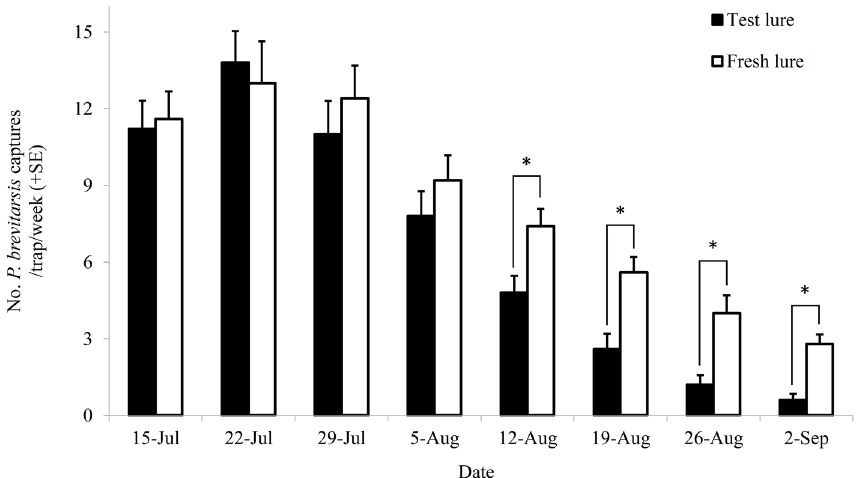
Figure 6. Captures of Protaetia brevitarsis adults in traps baited with test lures (with the lures aging during the assays) and fresh lures (changed at a 1-week interval) (mean + SE, N = 5) from 15 July to 2 September, 2018. The asterisks on the bars indicate significant differences in the total catches of female and male WSFCs ( P <